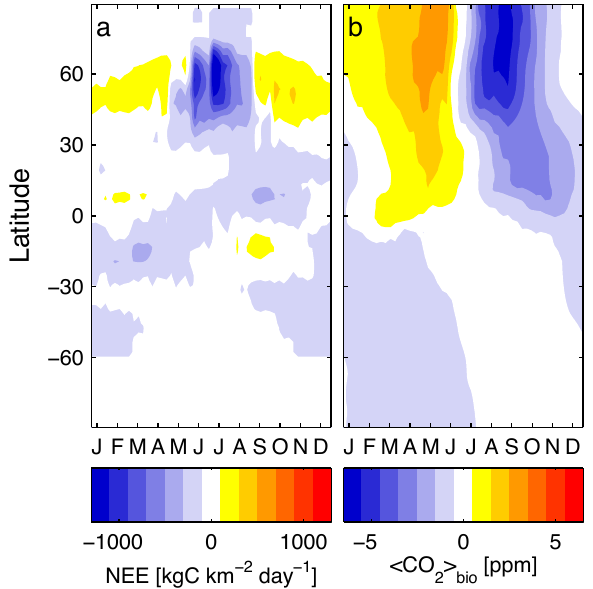
Fig. 1. (a) Net ecosystem exchange (NEE) as a function of latitude and month of the year. Strong temporal and spatial gradients in NEE characterize the Northern Hemisphere. Gradients are weaker in the tropics and Southern Hemisphere. The resulting h CO 2 i bio is shown in (b) . h CO 2 i bio has accordingly stronger spatial and tem- poral gradients in the Northern Hemisphere, and these gradients are stronger during summer than